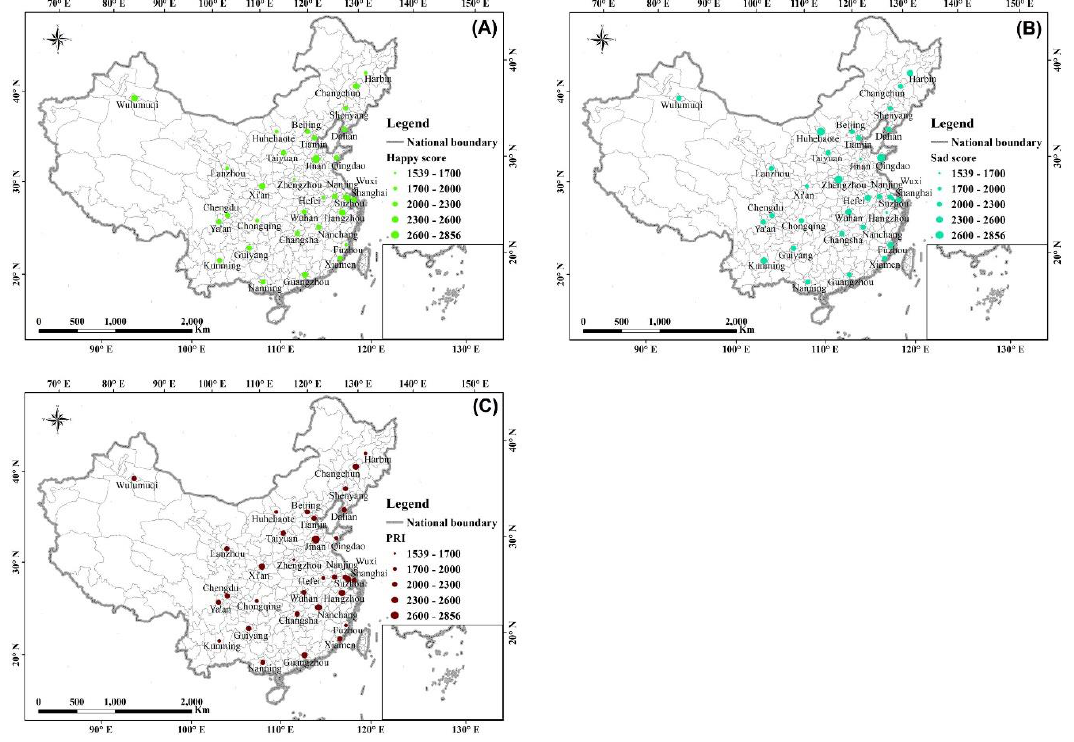
Figure 2. The geographical distribution of happy ( A ), sad ( B ), and positive response index (PRI; ( C )) in cities with 211-Project universities across mainland China.